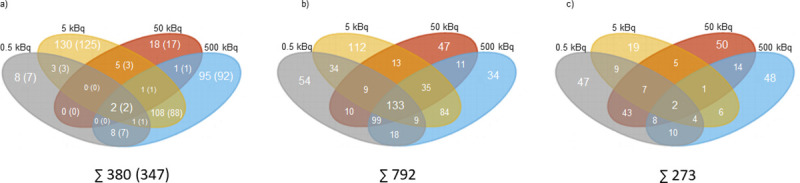
The number of statistically significant regulated transcripts and proteins in thyroid tissue and plasma 9 months after 131I administration in Sprague Dawley rats.Venn diagrams illustrating the distribution of the number of statistically significant a) regulated transcripts in thyroid tissue, with corresponding genes displayed in parentheses, b) expressed proteins in rat thyroid, and c) expressed proteins in rat plasma for 0.5 (in grey), 5 (in orange), 50 (in red) and 500 kBq (in blue).